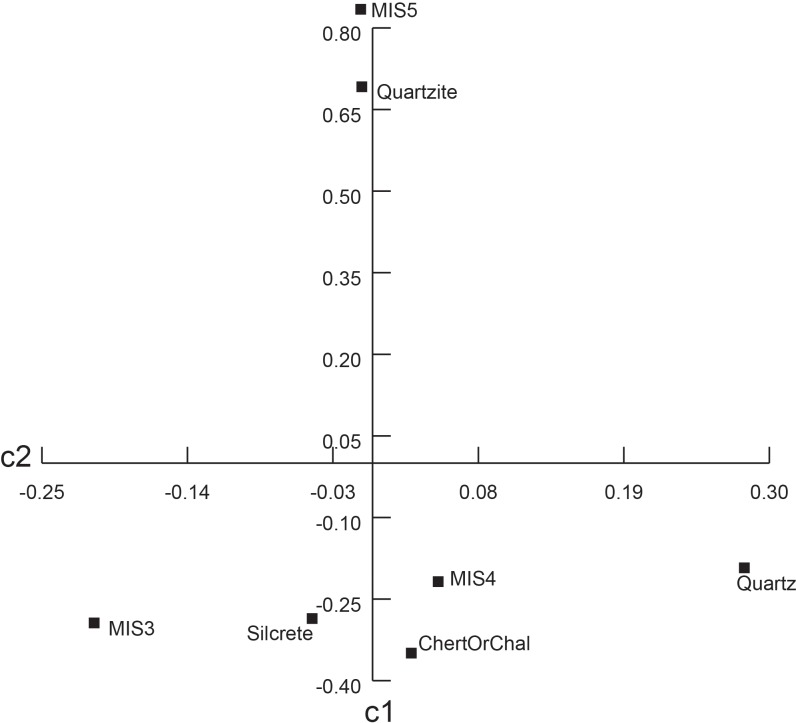
Correspondence plot of raw material types by MIS.c1 explains 96% of variation. c2 explains 4% of variation. Pearson Chi2 = 2815, p<0.001.